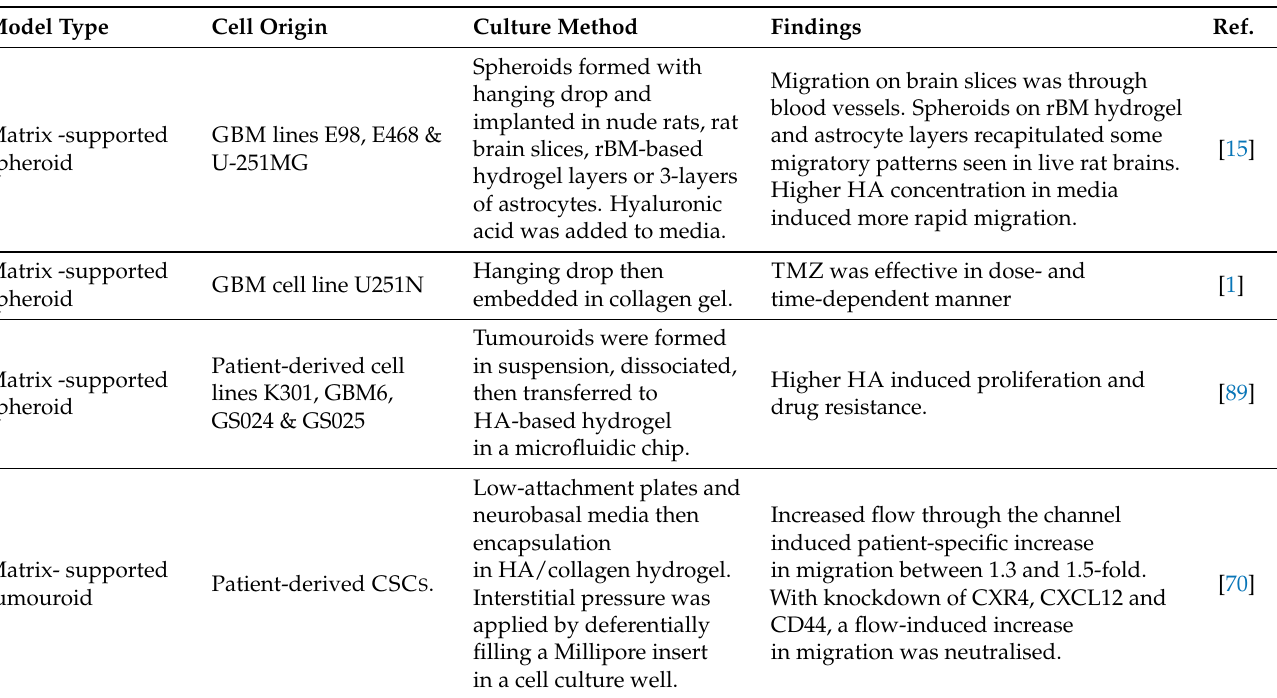
Table 4. Key methods for the formation of matrix-supported adult high-grade glioma spheroid and tumouroid models and the findings generated with their use. No matrix-supported models of paediatric HGG were found at the time of writing. Model